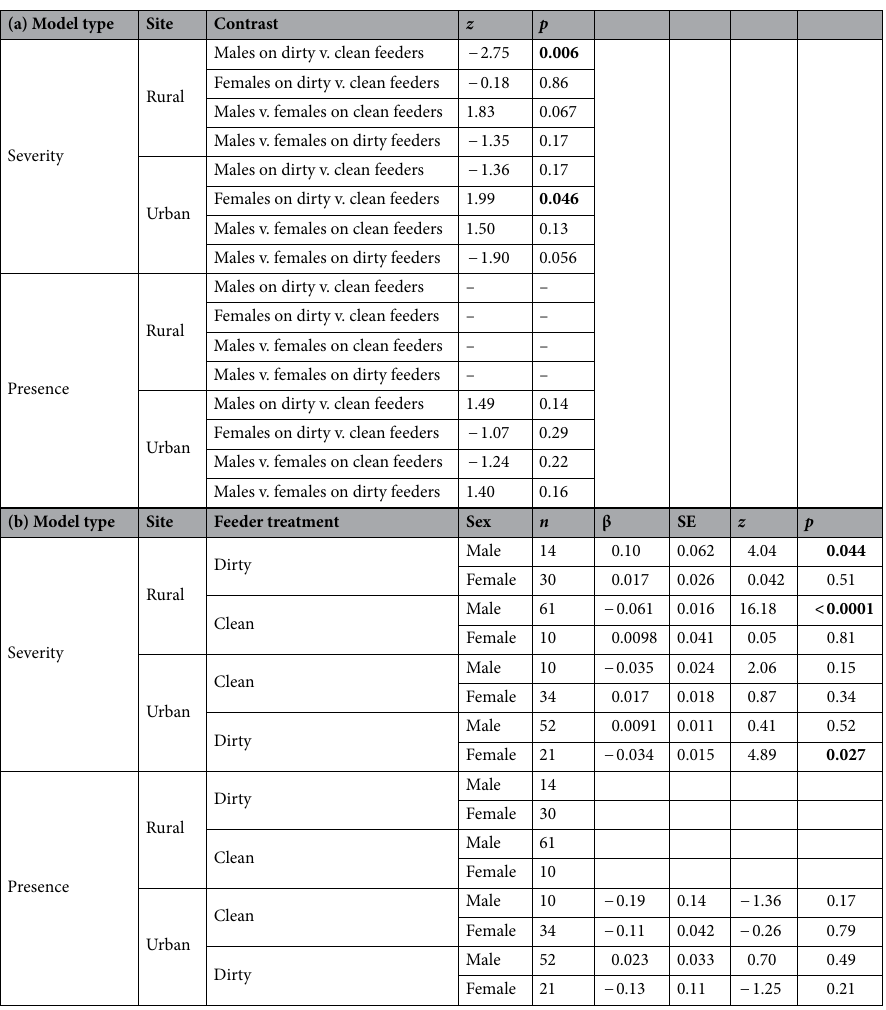
Table 2. Results of post-hoc analyses comparing disease state between birds of different sex, on the different feeder treatments, and over time within the treatments. (a) Pairwise Tukey tests of line-slope differences between groups (e.g. sexes, feeder treatments), for both our coccidia-severity and -presence models. (b) Univariate tests of line-slope differences from zero, for both our coccidia-severity and -presence models. Severity model results are again based on quasipoisson error terms when data were overdispersed. Rows containing dashes/lines instead of data represent models for which we found no statistically significant predictors (i.e. post-hoc tests are not appropriate). Boldfaced p -values indicate significance at α =